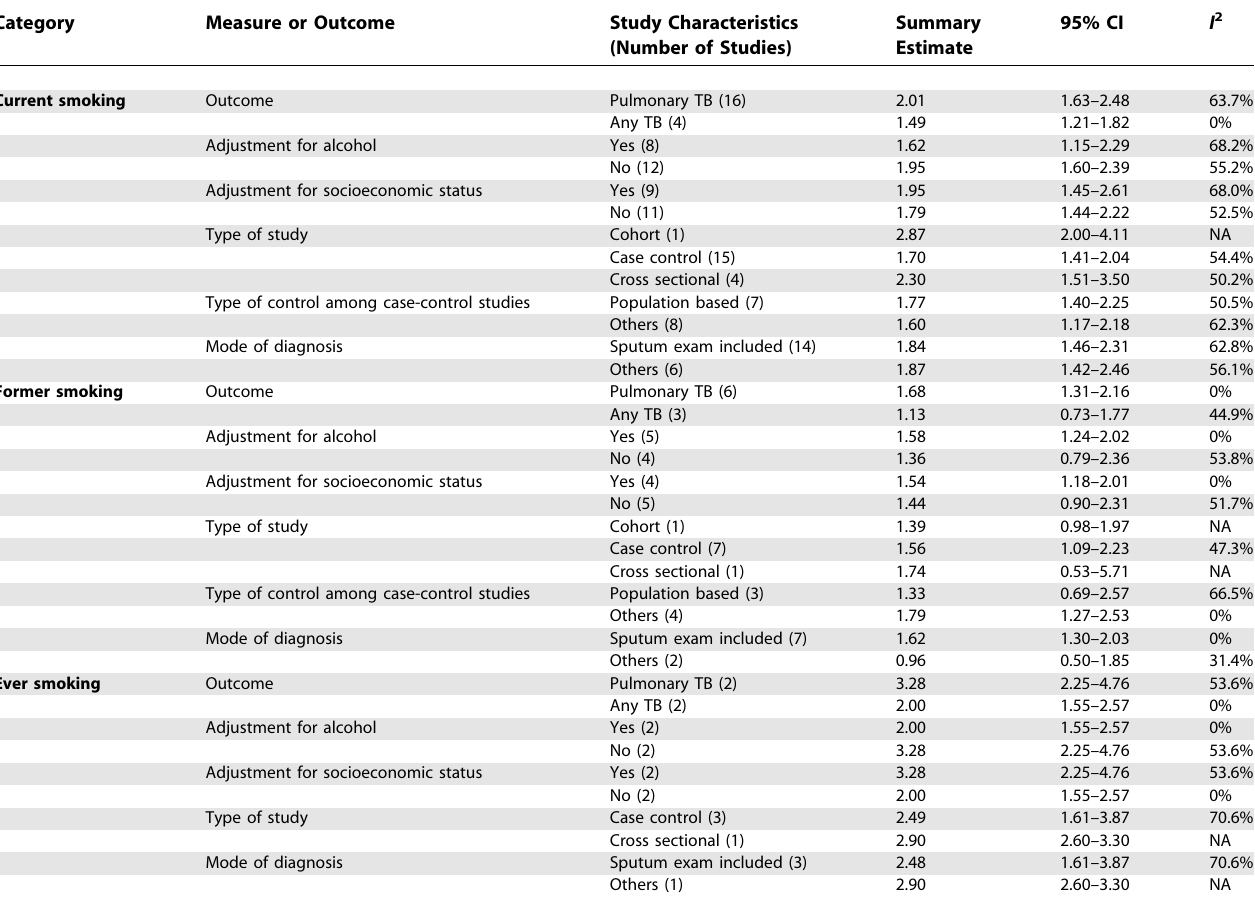
Table 3. Quality Assessment and Subgroup Analysis: Tobacco Smoking and TB Disease